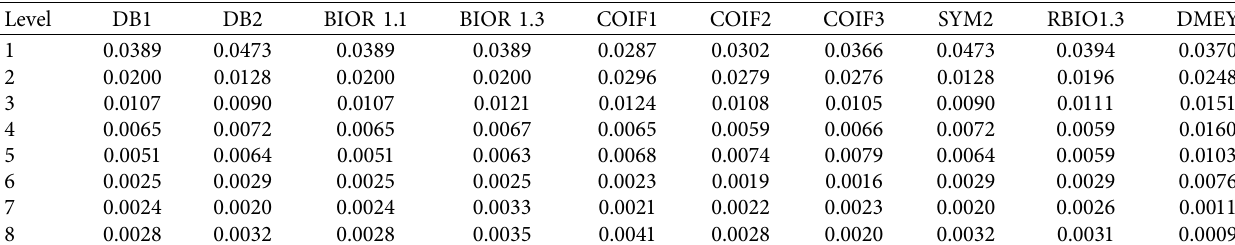
Table 2: Comparison of mother wavelet at different levels on the basis of ESE.